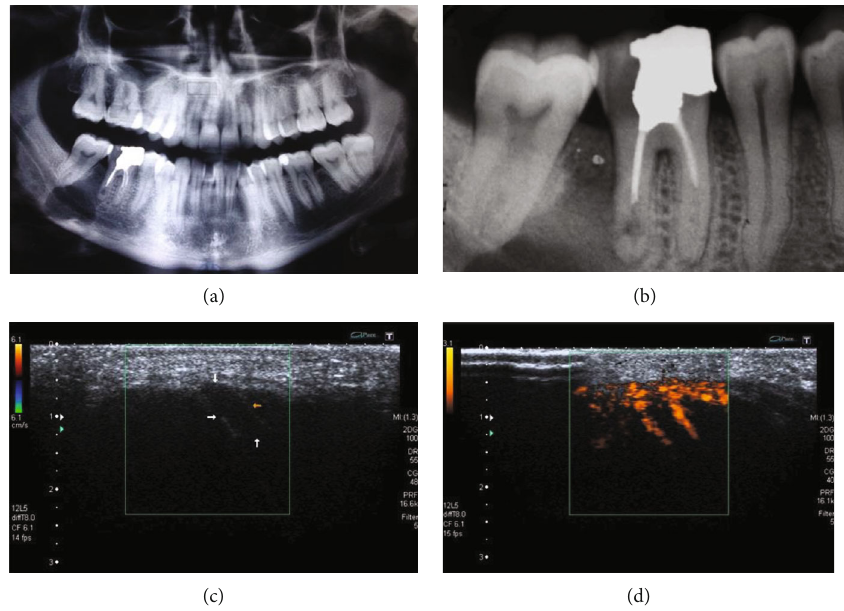
Figure 1: Images of the 27-year-old patient presenting an extensive asymptomatic lesion of the right posterior mandible. (a) The panoramic radiograph shows a well-de fi ned unilocular osteolytic lesion with sclerotic margins located between the two molar teeth and superimposed on the alveolar inferior nerve. (b) The periapical radiograph of the fi rst molar depicting inadequate root canal treatment with signs of perforation in the apical third of the distal root involved in the osteolytic lesion. (c) B-mode ultrasound examination showing a transonic lesion (arrows). (d) Power-Doppler image showing the presence of peripheral